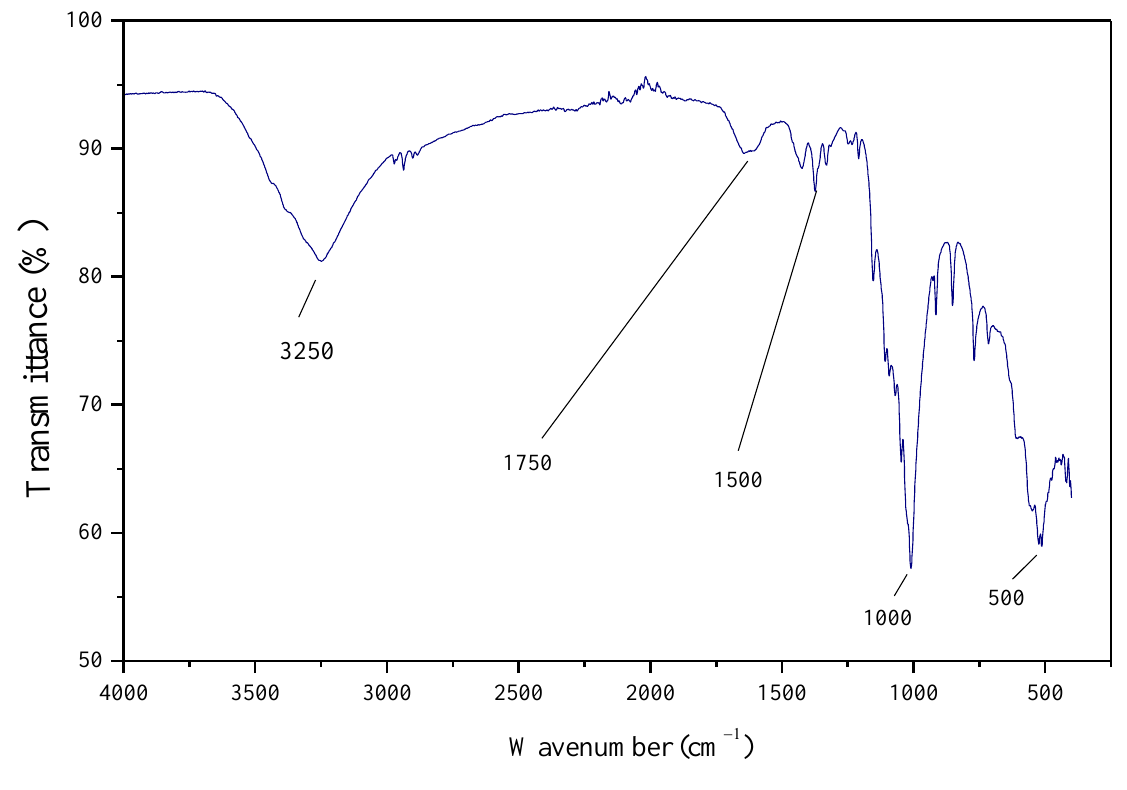
Figure 3. FT-IR analysis of Fe/Cu bimetallic nanoparticles.